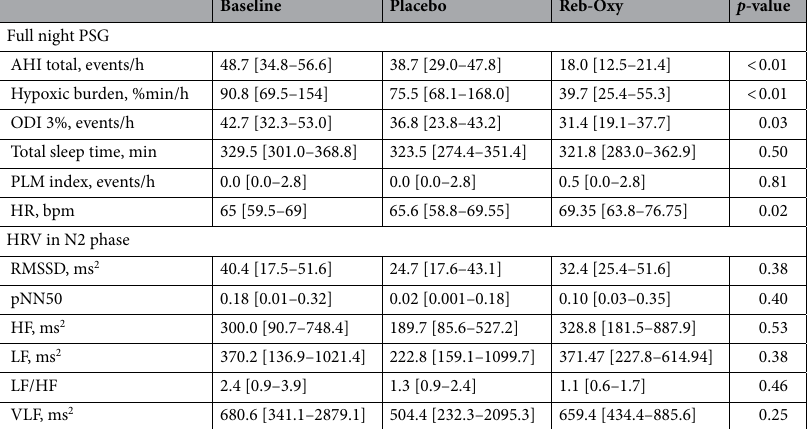
Table 2. Obstructive Sleep Apnea severity parameters (some reported from previous study 23 ), main sleep characteristics, and heart rate variability (HRV) at baseline, on placebo, and on active drugs combination (n = 16); HRV was assessed from EKG of nocturnal PSG during N2 sleep at baseline, on placebo, and on active drugs combination. reb–oxy = reboxetine plus oxybutynin; AHI = apnea–hypopnea index; ODI = oxygen desaturation index; PLM = periodic legs movements; HR = heart rate; SD = standard deviation; RMSSD = Root Mean Square of the Successive Differences; pNN50 = the proportion of number of pairs of successive NN (R-R) intervals that differ by more than 50 ms; HF = high frequency; LF = low frequency; VLF = very low frequency. Data are presented as median [interquartile] % changes are expressed as the median of percentage change. P values compare placebo versus reb-oxy. P -values are calculated by comparing the percentage changes from baseline observed in the placebo versus